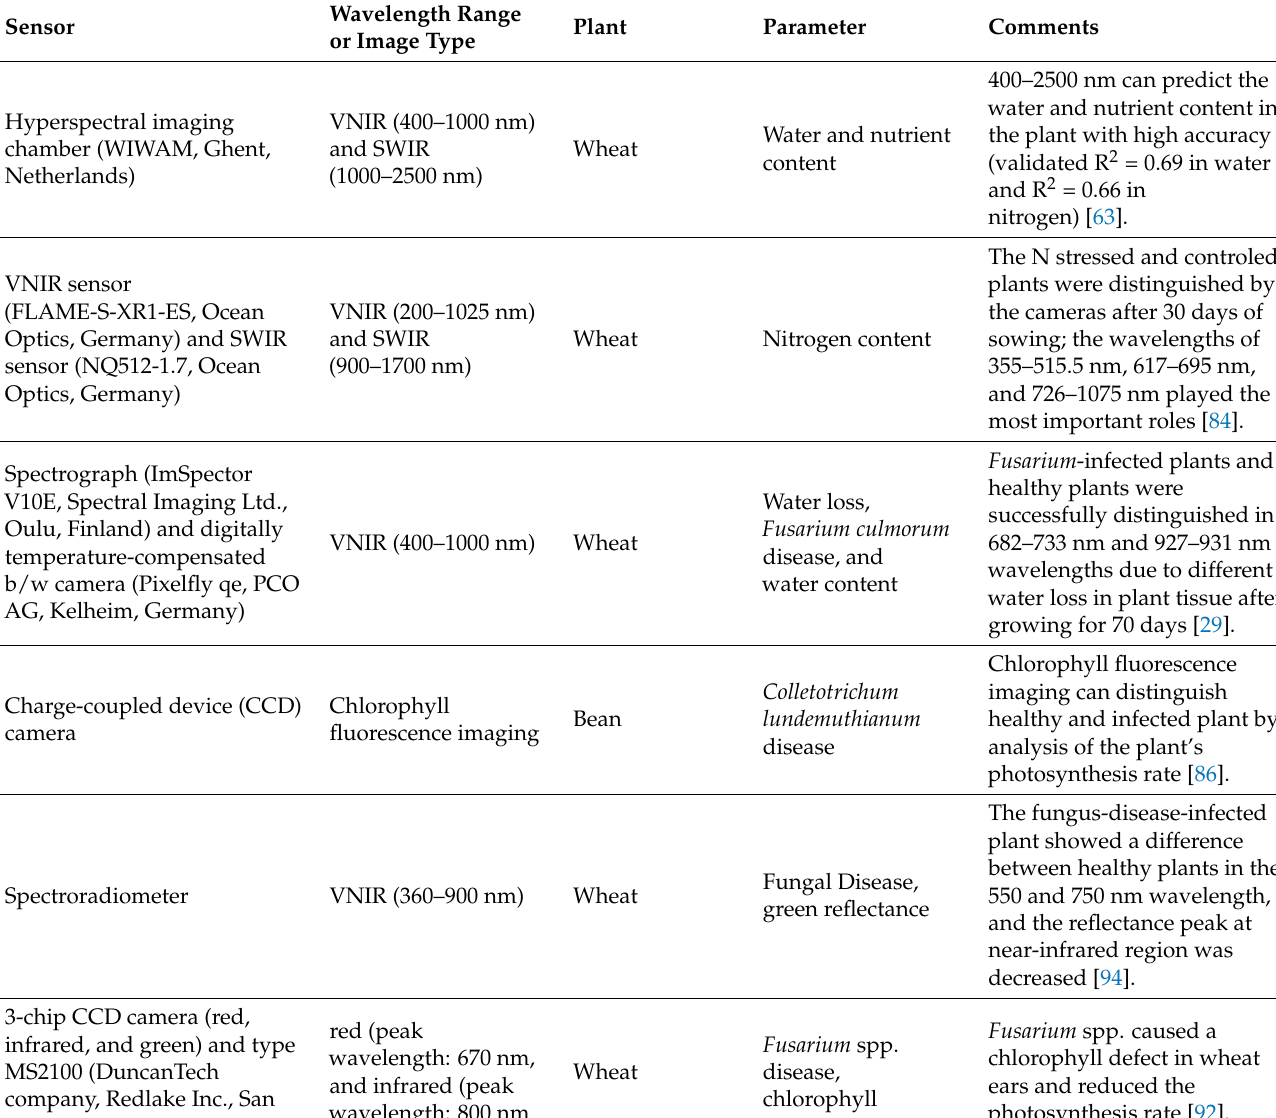
Table 1. Summary information of previous studies using HSI for measurement of water and nutrient content or Fusarium disease related trait discovery. Included are the sensors, related image types, or special wavelength and further